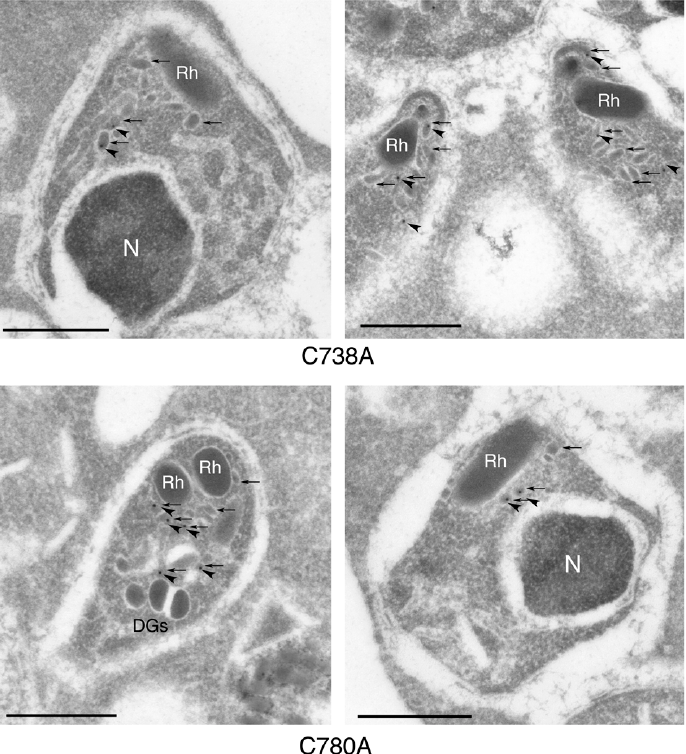
Figure 4. Immunoelectron microscopy of mature merozoites in schizonts obtained from P. yoelii transgenic parasite lines, C738A and C780A. PyEBL was probed with rat anti-PyEBL serum and a secondary antibody conjugated with gold particles. PyEBL was detected in the micronemes of each merozoite. N, DGs, and Rh indicate nucleus, dense granules, and rhoptry, respectively. Arrowheads and arrows indicate gold particles and micronemes, respectively. The scale bars indicate 500 nm.